Question: What form of chart is displayed?
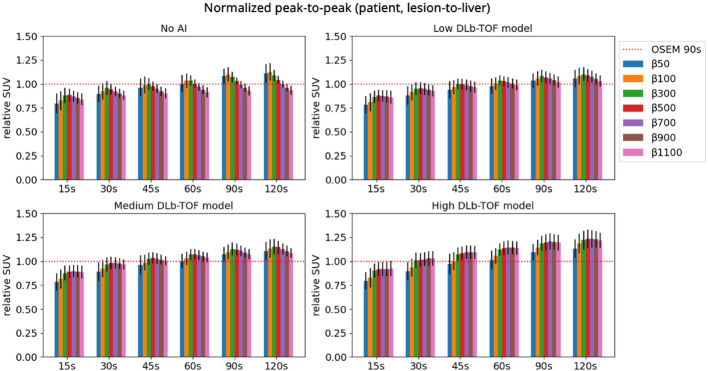
Answer: bar